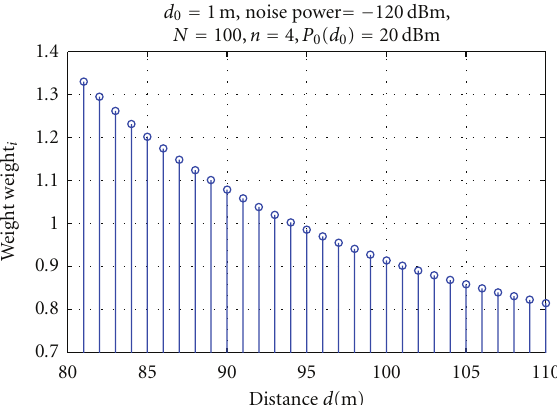
Figure 9: Assigned weight for CRs at di ff erent distance when weight variance = 0 .